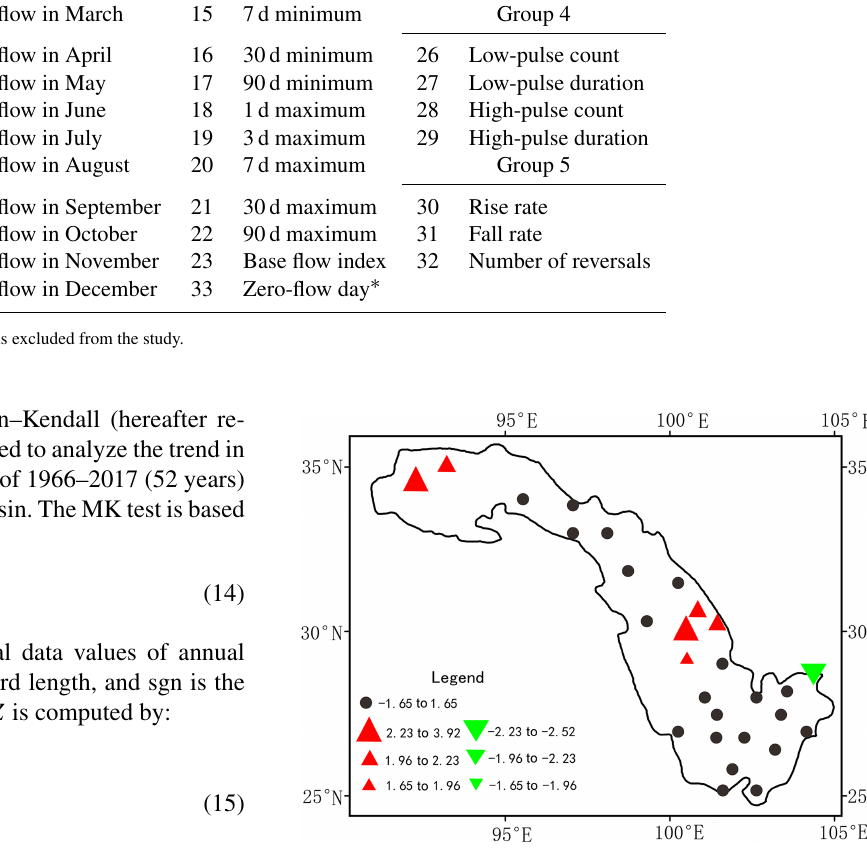
Figure 2. Precipitation changes in the Jinsha River basin. Trend of annual precipitation at 28 stations between 1966 and 2017 where upward (downward) triangles indicate positive (negative) trends from the MK test. The size of the triangles depicts the significance levels 10% (small), 5% (medium) and 1% (large). Black dots show stations with no trends or trends below the 10% significance level. The value in the legend is the standardized statistic Z